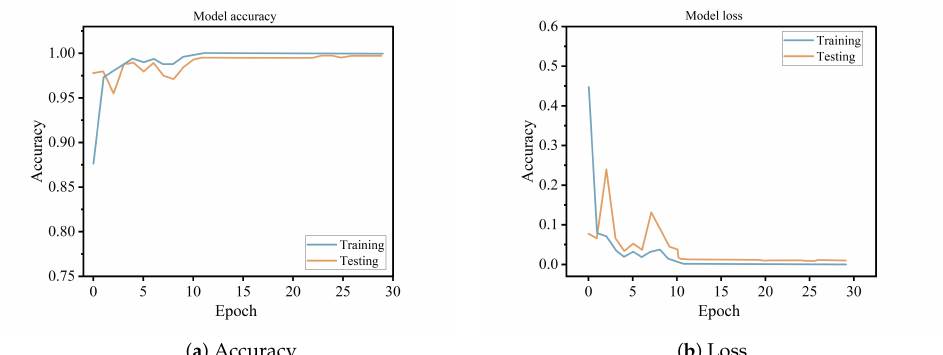
Figure 12. Model accuracy and loss for multi-signal feature fusion